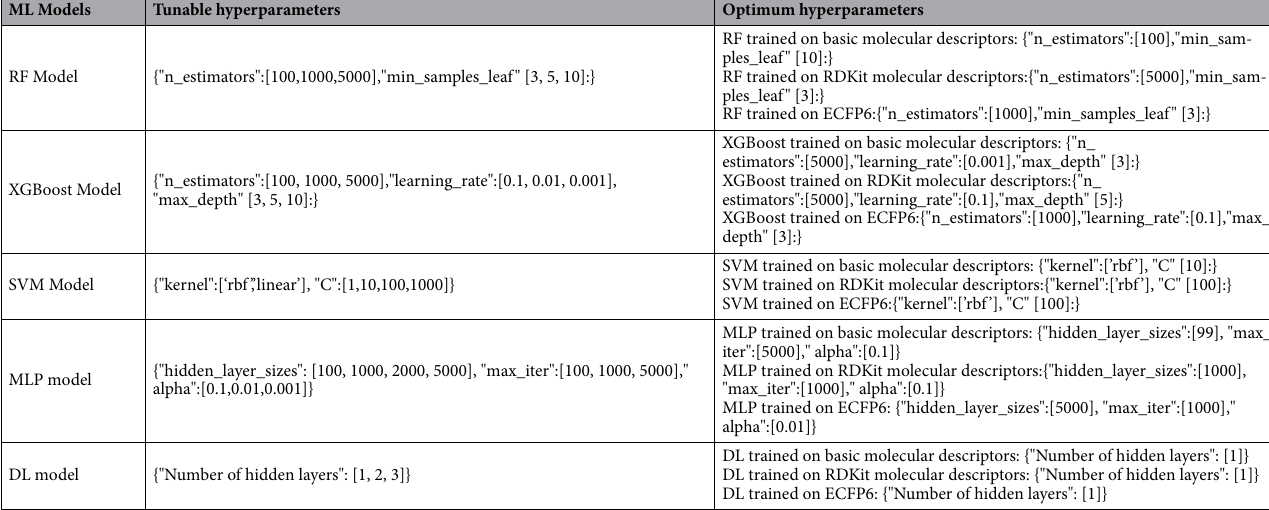
Table 1. Selected hyperparameters used for tuning the machine learning algorithms together with the best performing values of these